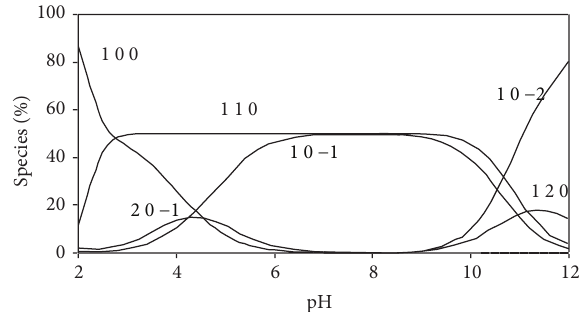
Figure 1: Concentration distribution of various species as a func- tion of pH in the dimethyltin(IV) complexes, (at concentrations of 1.25 mmole/liter for DMT and 2.5 mmole/liter for BIMP) at 25 ∘ C.